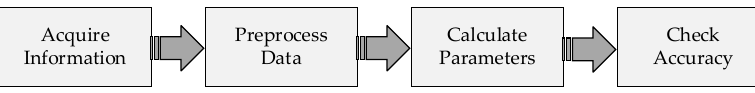
Figure 1. Online estimation process of electric meter errors.